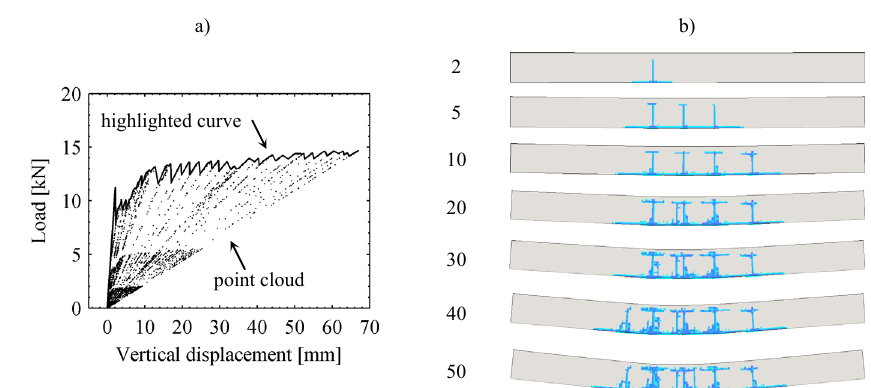
Figure 5: a) Load-displacement diagram and b) contour plots of the reduced E-modulus (crack pattern) resulting from the computational